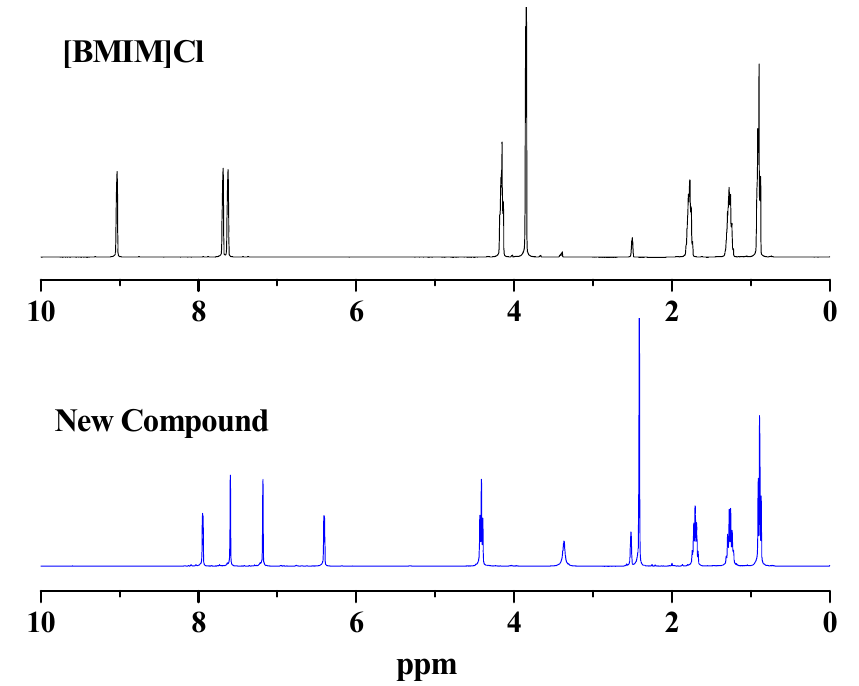
Figure 1. Comparison the 1 H-NMR spectra of [Bmim]Cl and the new compound in DMSO-d at 30 6